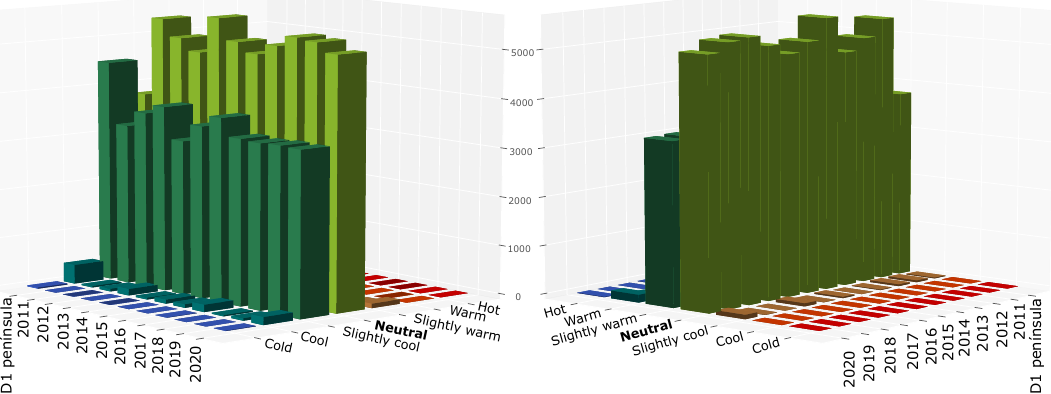
Figure 4. Comfort results taking into account the NBE CTE-79 standard and the Pamplona actual meteorological years (AMY).